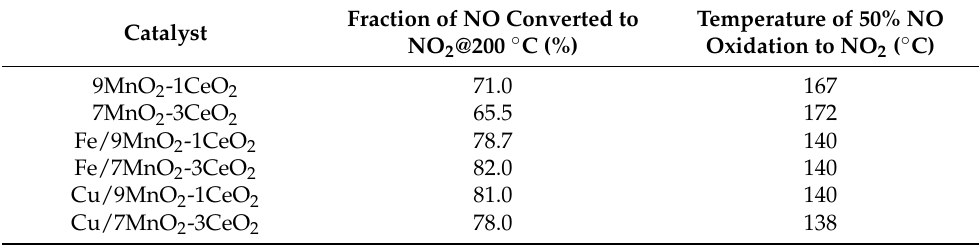
– nCeO catalysts. 2 2